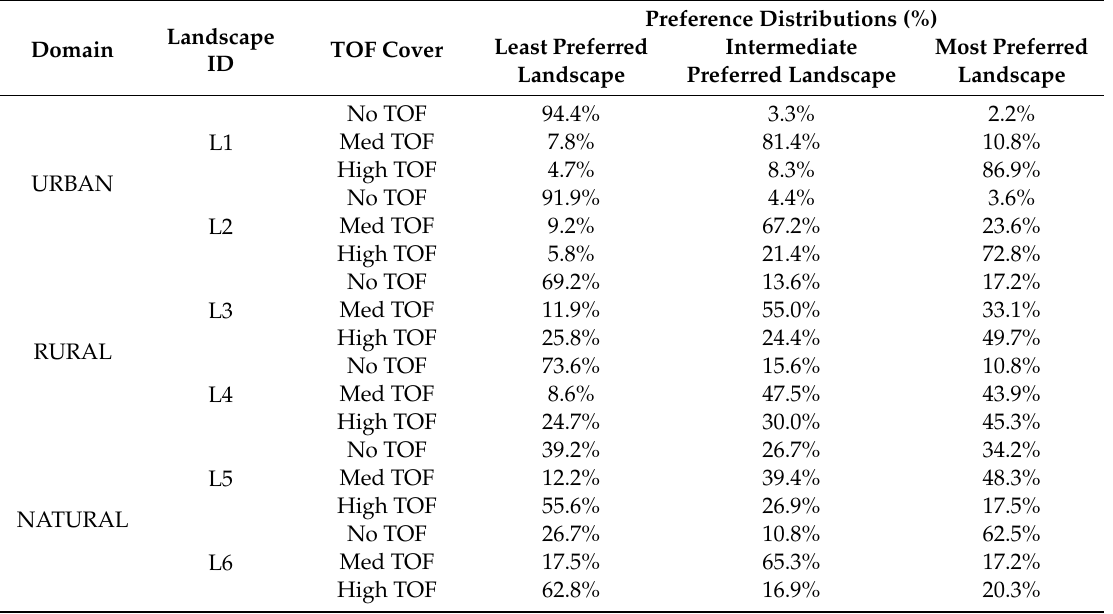
Table 1. Preference distribution of the overall sample of respondents recorded in the visual choice